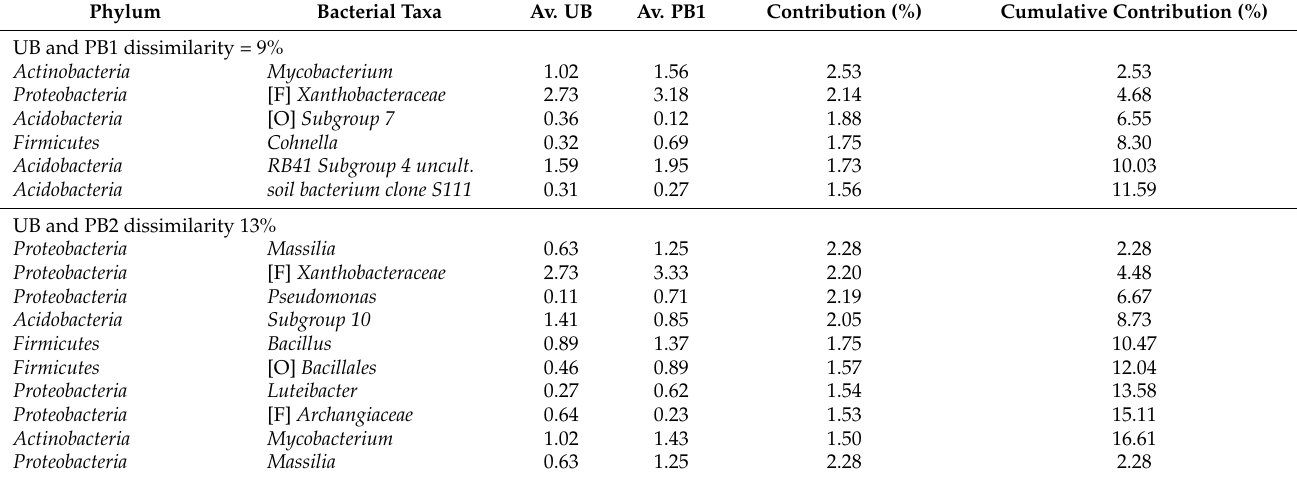
Table 5. Pairwise SIMPER analysis with comparison of the three treatments in terms of relative abundance of bacterial phyla and genera, or lowest ranked taxonomic level. Percent dissimilarity and percent cumulative total contribution are shown. Contributions less than 1.5% are not